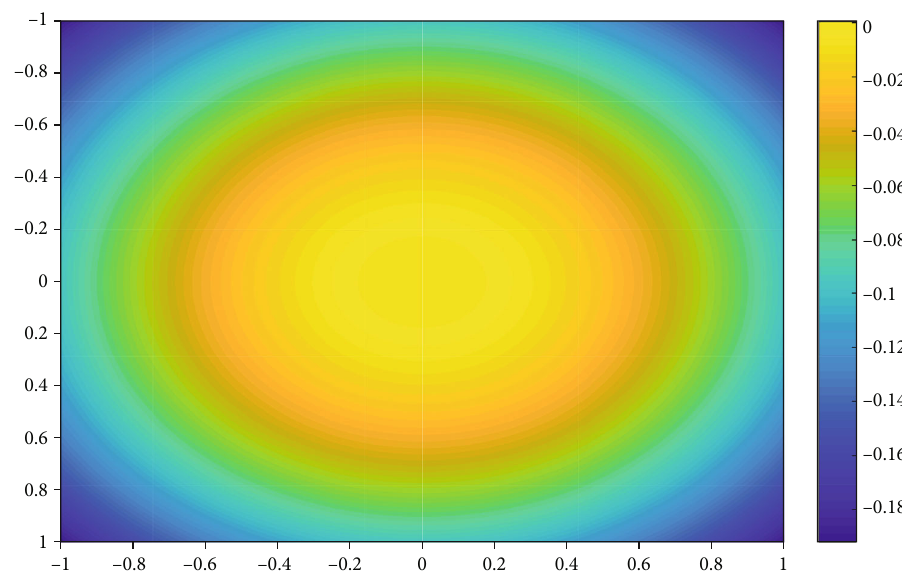
Figure 2: Errors of approximation of network operators (6) with n = 1000